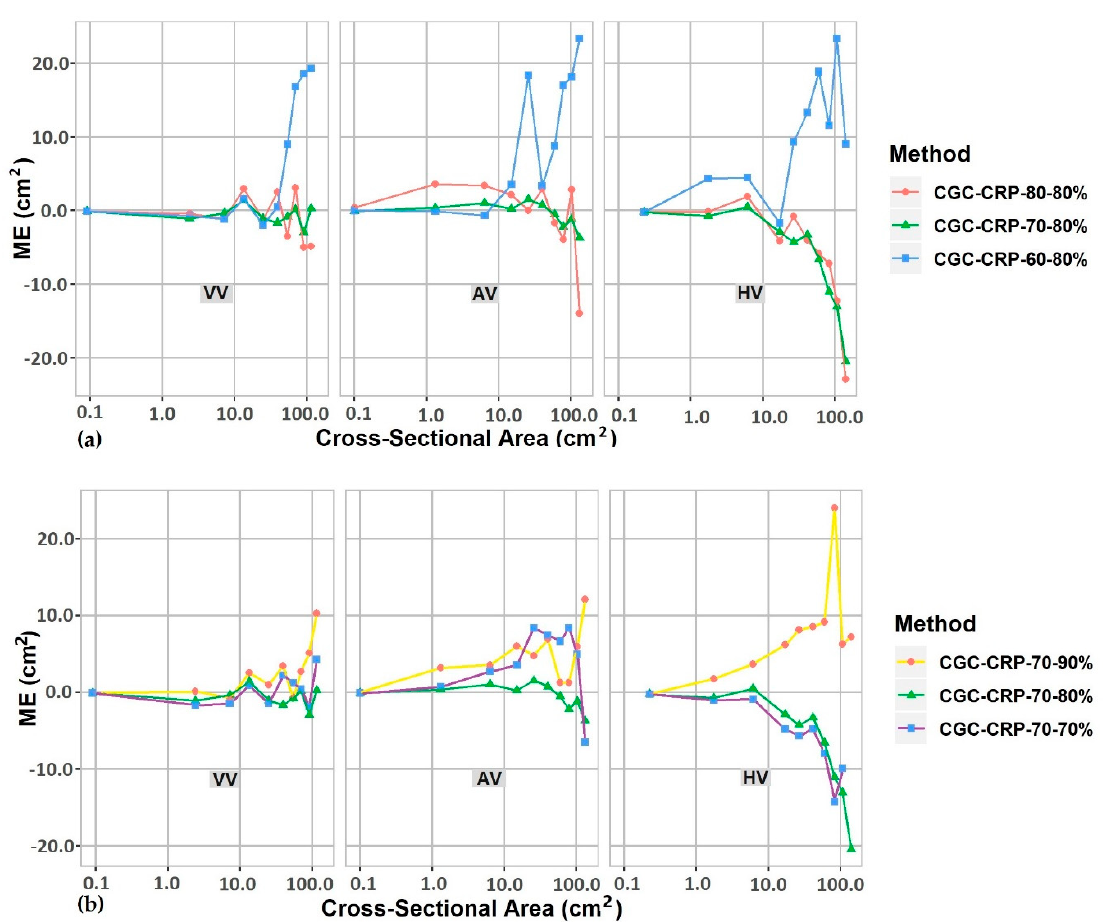
Figure 7. Mean error (ME) of cross section area (cm 2 ) derived from the CGC-CRP method with ( a ) selected camera shooting angle settings and ( b ) selected image overlapping rate settings. The x-axis is in logarithmic scale. VV: vertical channel, AV: angled channel, HV: horizontal channel.